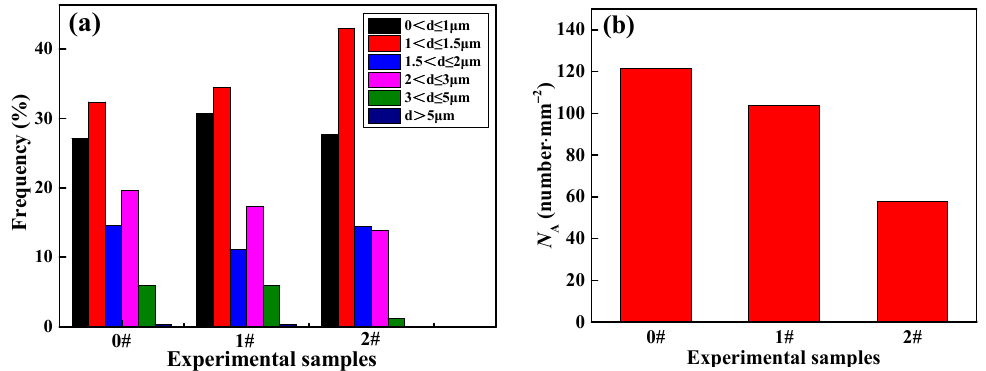
Figure 2. Size and number distributions of inclusions in the 0#–2# experimental samples: ( a ) diameter distribution of inclusions; ( b ) number of inclusions per unit area.